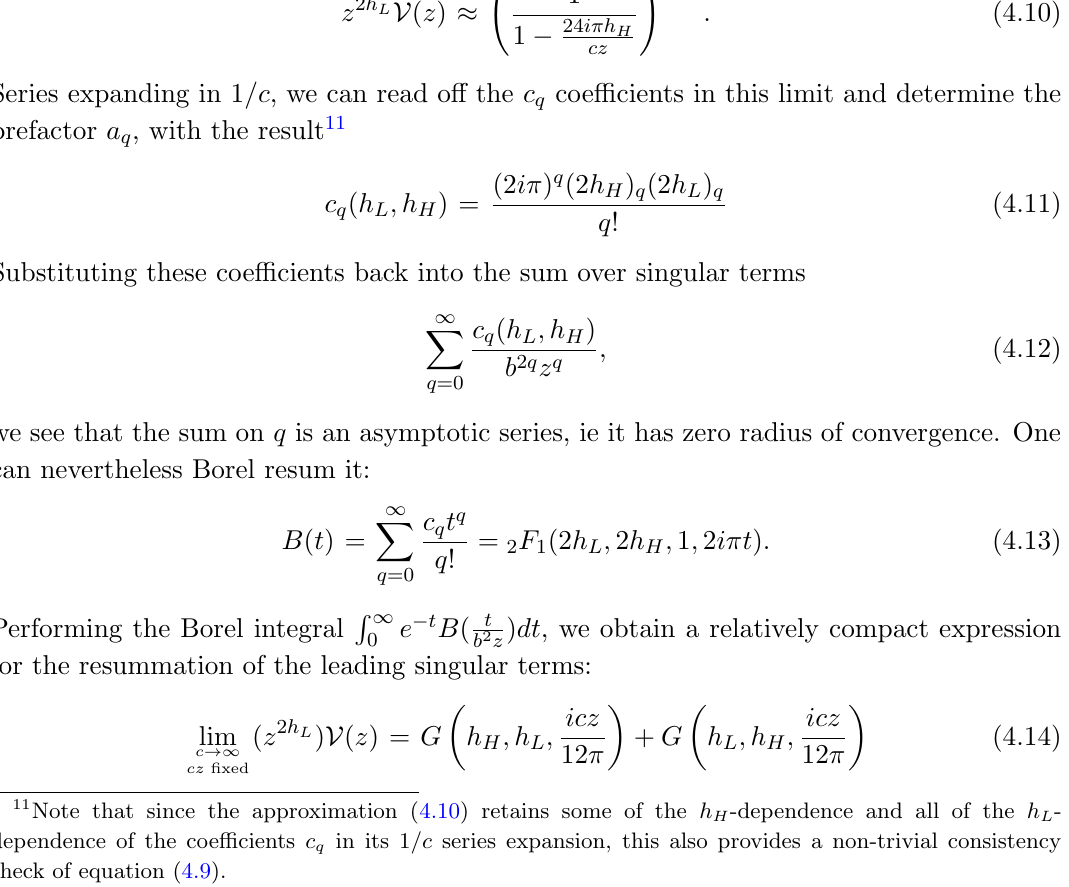
Figure 2 . Plots comparing the exact behavior from eq. (4.14) (black, dashed) for 1 (cid:0) F ( t ) in the limit c ! 1 with cz (cid:12)xed, to the heavy-light approximation (4.10) (red, solid). Left : h L = h H = 1 Right : h L = 3 ; h H = 3 . F ( t ) and t are as in (cid:12)gure 1. Note that both curves only include 2 10 contributions from the vacuum block, neglecting double-trace operators which could a(cid:11)ect an AdS 3